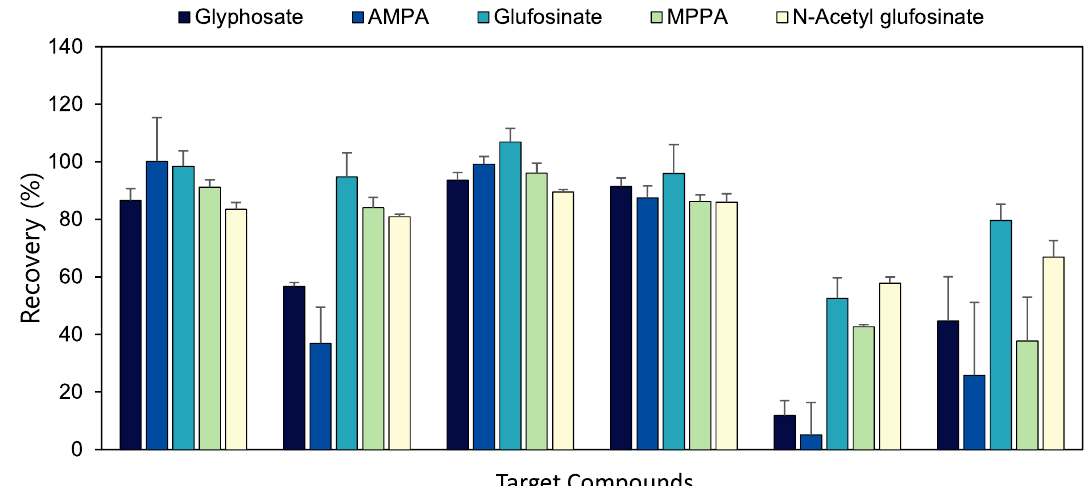
Figure 4. Recoveries of glyphosate, aminomethylphophonic acid (AMPA), glufosinate, 3-methylphosphinico- propionic acid (MMPA), and N -acetyl glufosinate obtained from seven different clean-up procedures after extraction of samples with acidified DW (15 mL) with 100 µL formic acid and MeCN (5